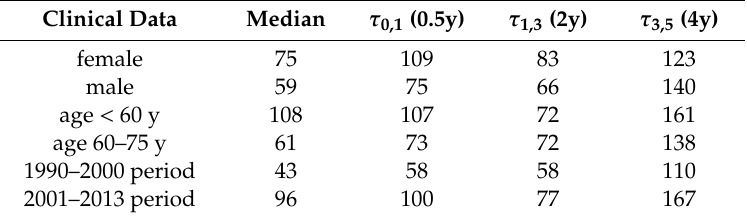
Table 3. Calculated τ 0,1 (0.5), τ 1,3 (2) and τ 3,5 (4) in months from OS data by Nafteux et al. ([17], Table